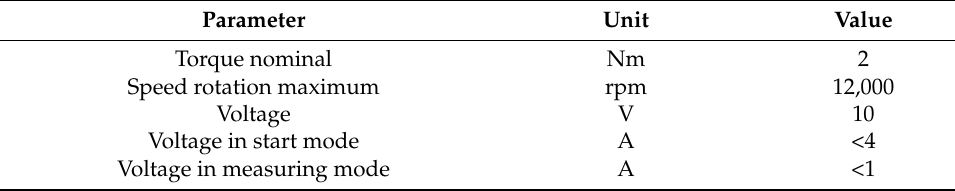
Table 4. Torque sensor HBM Stator